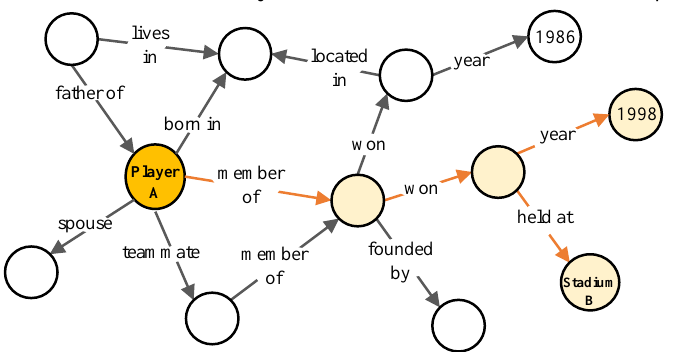
Figure 1. An example of a KBQA task. For the question “In which stadium did Player A’s team win the 1998 World Championship?”, the orange circle and the orange line represent the inference process from Player A (the topic entity) to Stadium B (the